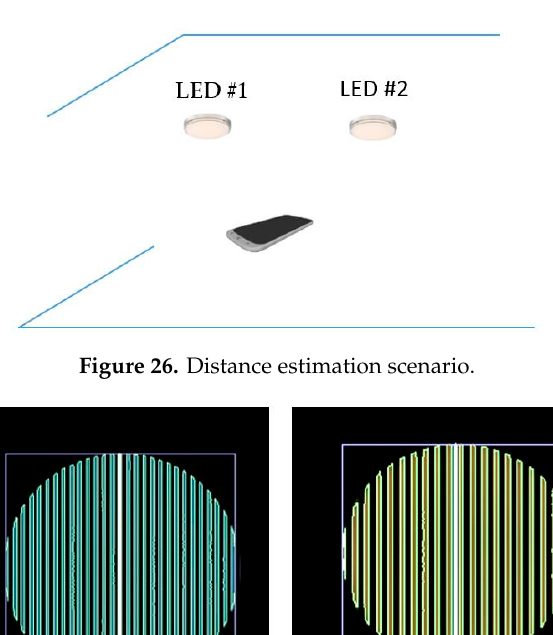
Figure 27 . ROI contour feature. ( a ) Captured image of 4 kHz signal. ( b ) Captured image of 2 kHz signal.